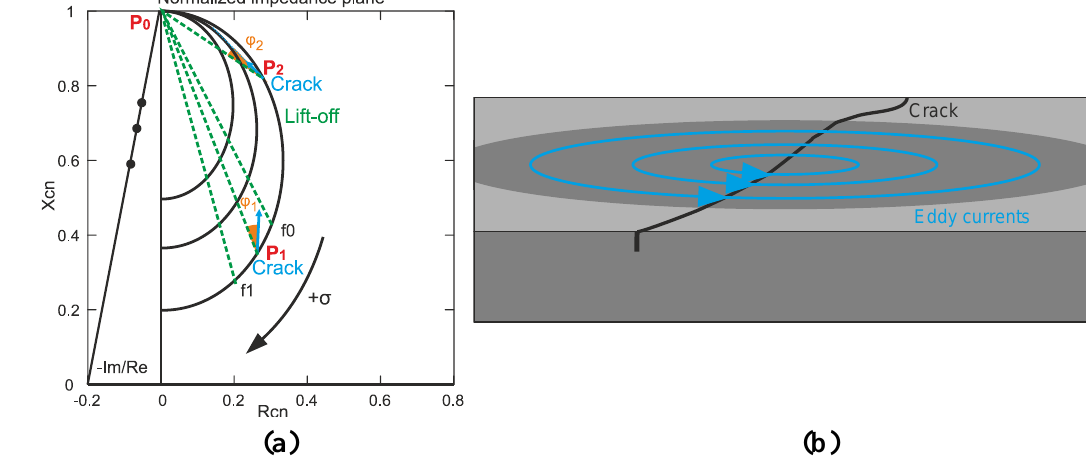
Figure 2. (a) Normalized impedance plane. Lift-off curves and crack displacement at impedance plane for two values of conductivity P1 and P2 (adapted from [12]). (b) Altered eddy current flow by a crack on the